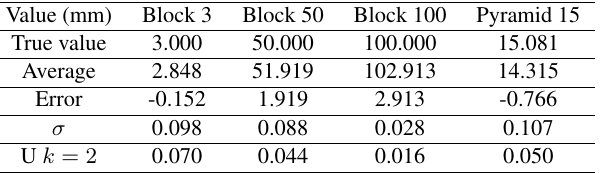
Table 5. Results of Fringe Profilometry Technique.